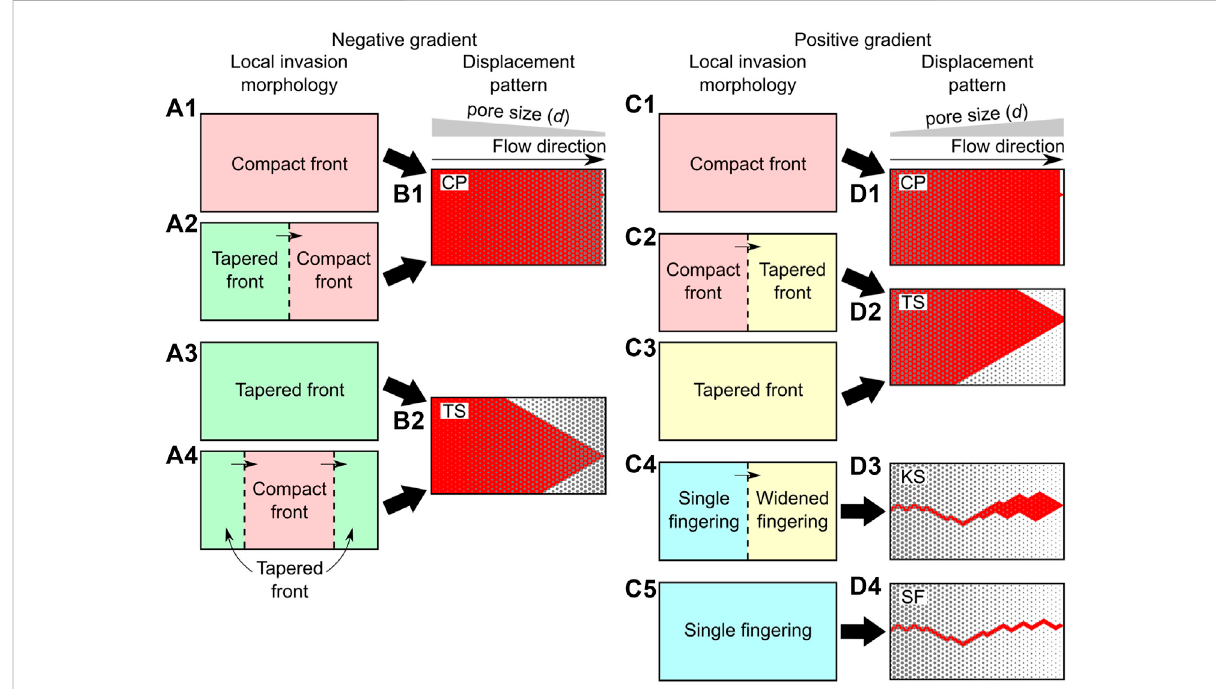
FIGURE 7 Link local invasion morphology to displacement pattern in the ordered porous media. All combinations of the local invasion morphologies are presented in negative gradient porous media (A) and positive gradient porous media (C) . Red, green, and blue indicate the compact front, tapered front, and single fi ngering, respectively. Yellow indicates that in this zone, both the tapered front and the widened fi ngering can occur. The corresponding displacement patterns are also presented in negative gradient porous media (B) and positive gradient porous media (D) .